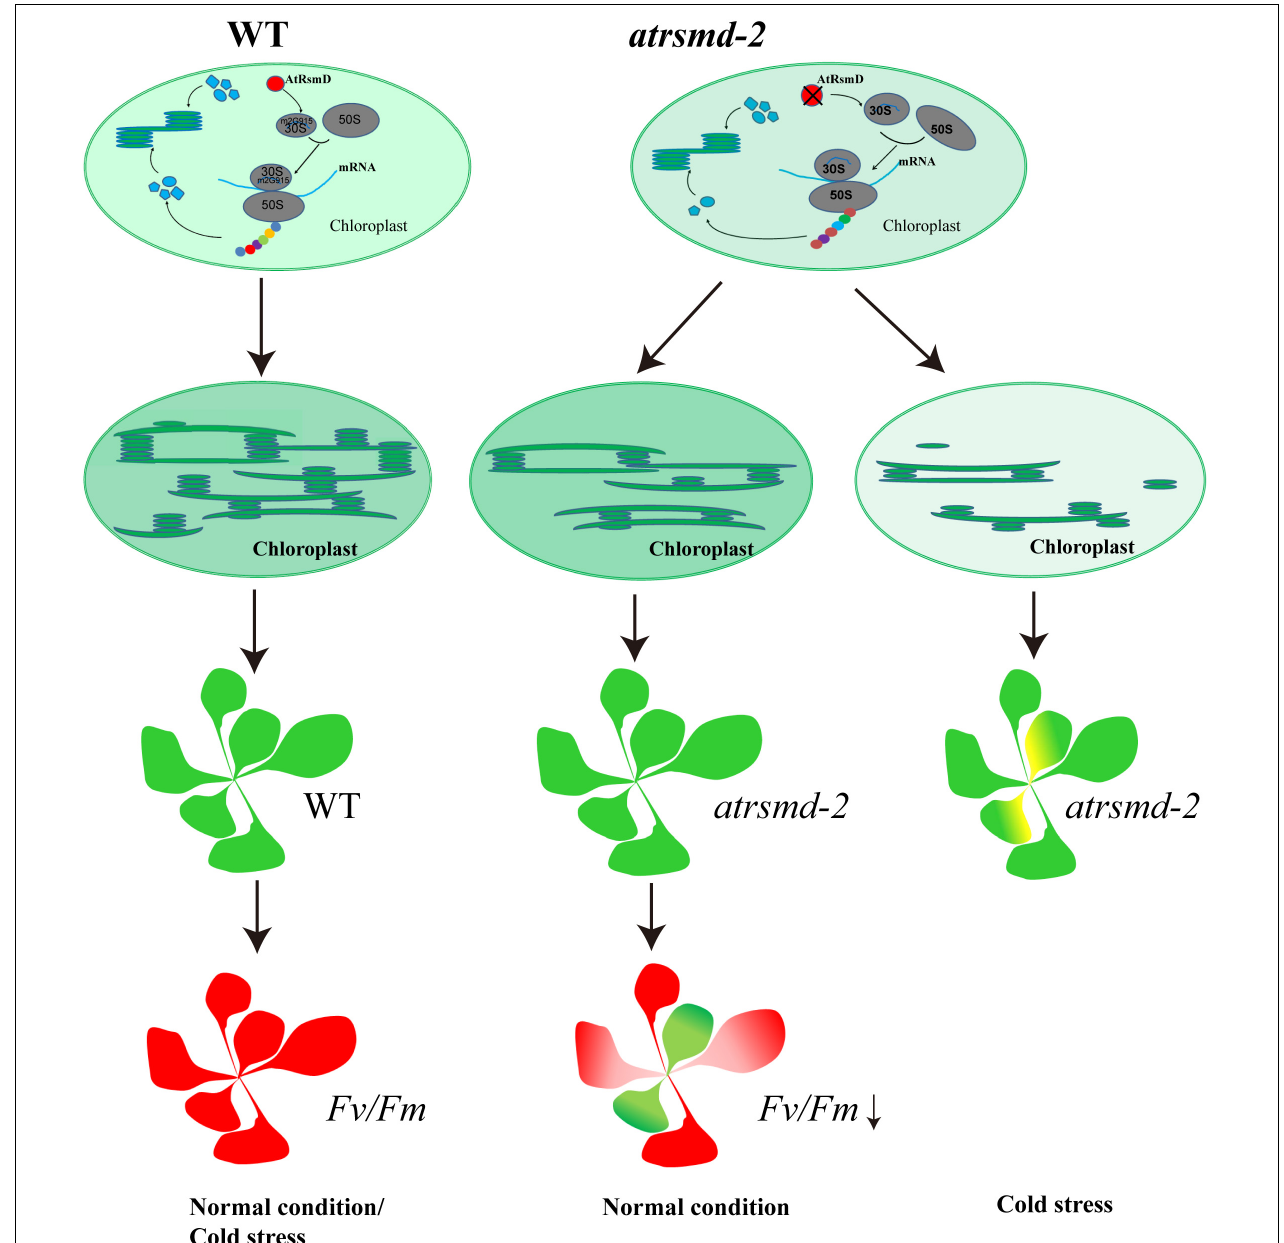
FIGURE 9 | A putative working model for AtRsmD in chloroplasts. AtRsmD is essential for the methylation of the 16S rRNA m 2 G915 site (Ngoc et al., 2021b), which ensures the rapid synthesis of chloroplast-encoded photosynthetic proteins, such as D1, D2, CP43, and CP47. In the atrsmd-2 mutant, absence of AtRsmD might reduce the synthesis of these photosynthetic proteins and affect the formation of the thylakoids, which may cause decreased photosynthetic efficiency. Cold stress aggravated the effect of AtRsmD knockout on chloroplast translation, which blocked chloroplast development in the atrsmd-2